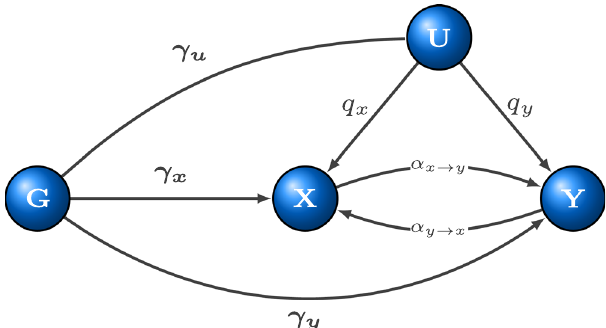
Fig. 1 Schematic representation of the extended structural equation model (SEM). X and Y are two complex traits under scrutiny with a latent (heritable) confounder U with causal effects q x and q y on them. G represents genetic variants, with effects γ x , γ y and γ u , respectively. Traits X and Y have causal effects on each other, which are denoted by α x → y and α y → x